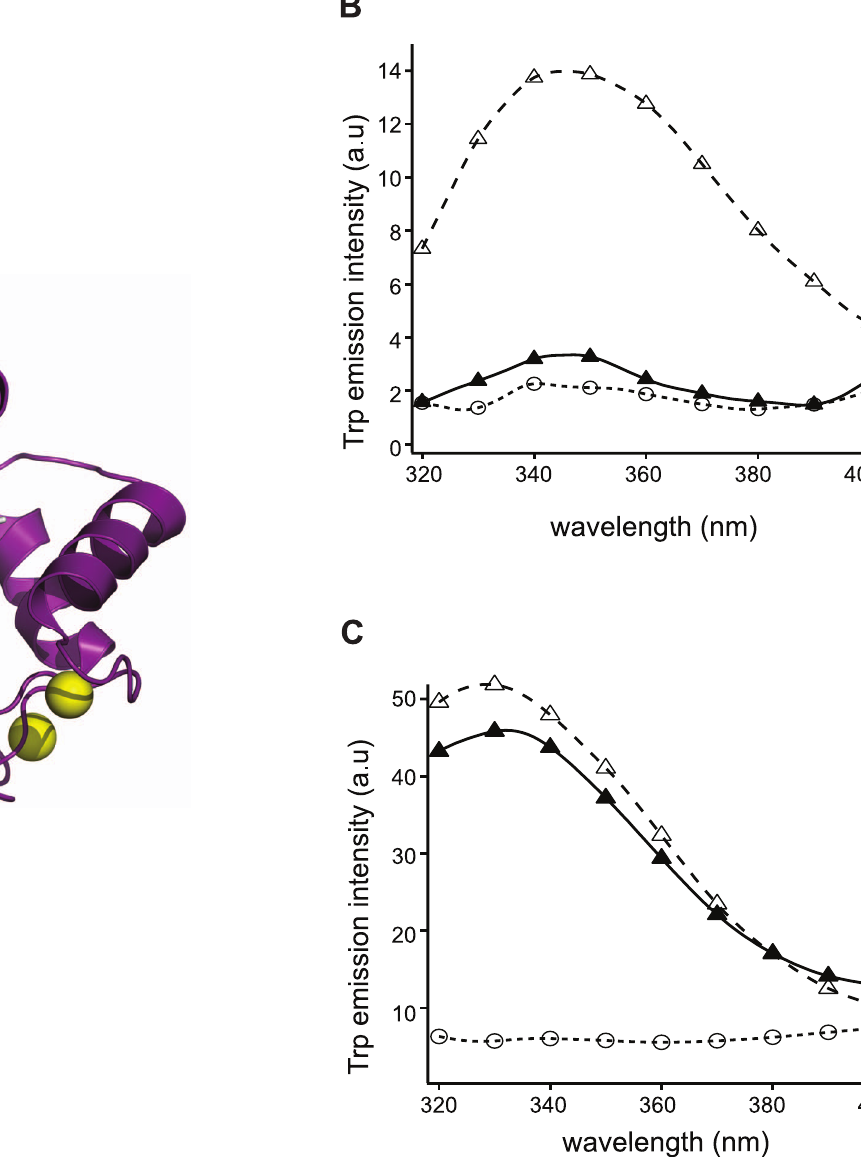
Figure 3. Differential FRET between L-selectin fragments and CaM in membrane and aqueous conditions. A, a ribbon diagram showing the proximity of Trp 315 of LSEL15 and Lys 75 of CaM in the CaM/LSEL15 complex structure (PDB ID: 2LGF). The LSEL15 peptide is shown in green, and CaM in purple. Four calcium ions are shown as yellow spheres. The side chains of Trp 315 and Lys 75 are shown in sticks, with the dashed line connecting the N e 1 atom in Trp 315 and the N f atom in Lys 75 . B, Trp emission spectra of 26 nM LSEL15 mixed with 104 nM unlabeled CaM in 10 mM MOPS, 100 mM NaCl, 0.3 mM CaCl 2 , pH 7.4 ( n ), of 104 nM I-CaM alone in the same buffer ( # ) and of 26 nM LSEL15 mixed with 104 nM I-CaM in the same buffer ( m ). C, Trp emission spectra of 26 nM CLS/POPC (1/1000 molar ratio) mixed with 104 nM unlabeled CaM in the same buffer as in (B) ( n ), of 10 m M I-CaM alone with empty POPC liposome ( # ), and of 26 nM CLS/POPC mixed with 10 m M I-CaM ( m ). All emission spectra were obtained with the excitation wavelength at 295 nm and each was the average of 3 scans. All spectra were corrected for background fluorescence from the buffer. doi:10.1371/journal.pone.0062861.g003 bound to I-CaM in this experiment. Assuming there is no FRET produce the donor-only and donor/acceptor spectra, respectively. between I-CaM and unbound CLS, the actual FRET efficiency of I-CaM mixed with 26 m M empty POPC liposome was used to Trp 315 and IAEDANS in the I-CaM/CLS/POPC complex produce the acceptor-only spectrum. Comparison of these Trp emission spectra showed that the emission of Trp 315 in CLS was should be adjusted to 0.26 6 0.03, which corresponds to a distance quenched slightly by I-CaM (Fig. 3C). The observed FRET of 26.0 6 0.5 A ˚ between the two probes. This distance is efficiency was 0.22 6 0.02. Due to the limited availability of I-CaM, significantly longer than that between the same groups in the I- 10 m M instead of a higher concentration was used in this CaM/LSEL15 complex, indicating that CaM in the CaM/CLS/ measurement. With a dissociation constant of approximate POPC complex adopts a distinctly different conformation from 2.0 m M [28], it was expected that 83% of CLS/POPC were that in the CaM/LSEL15 complex.